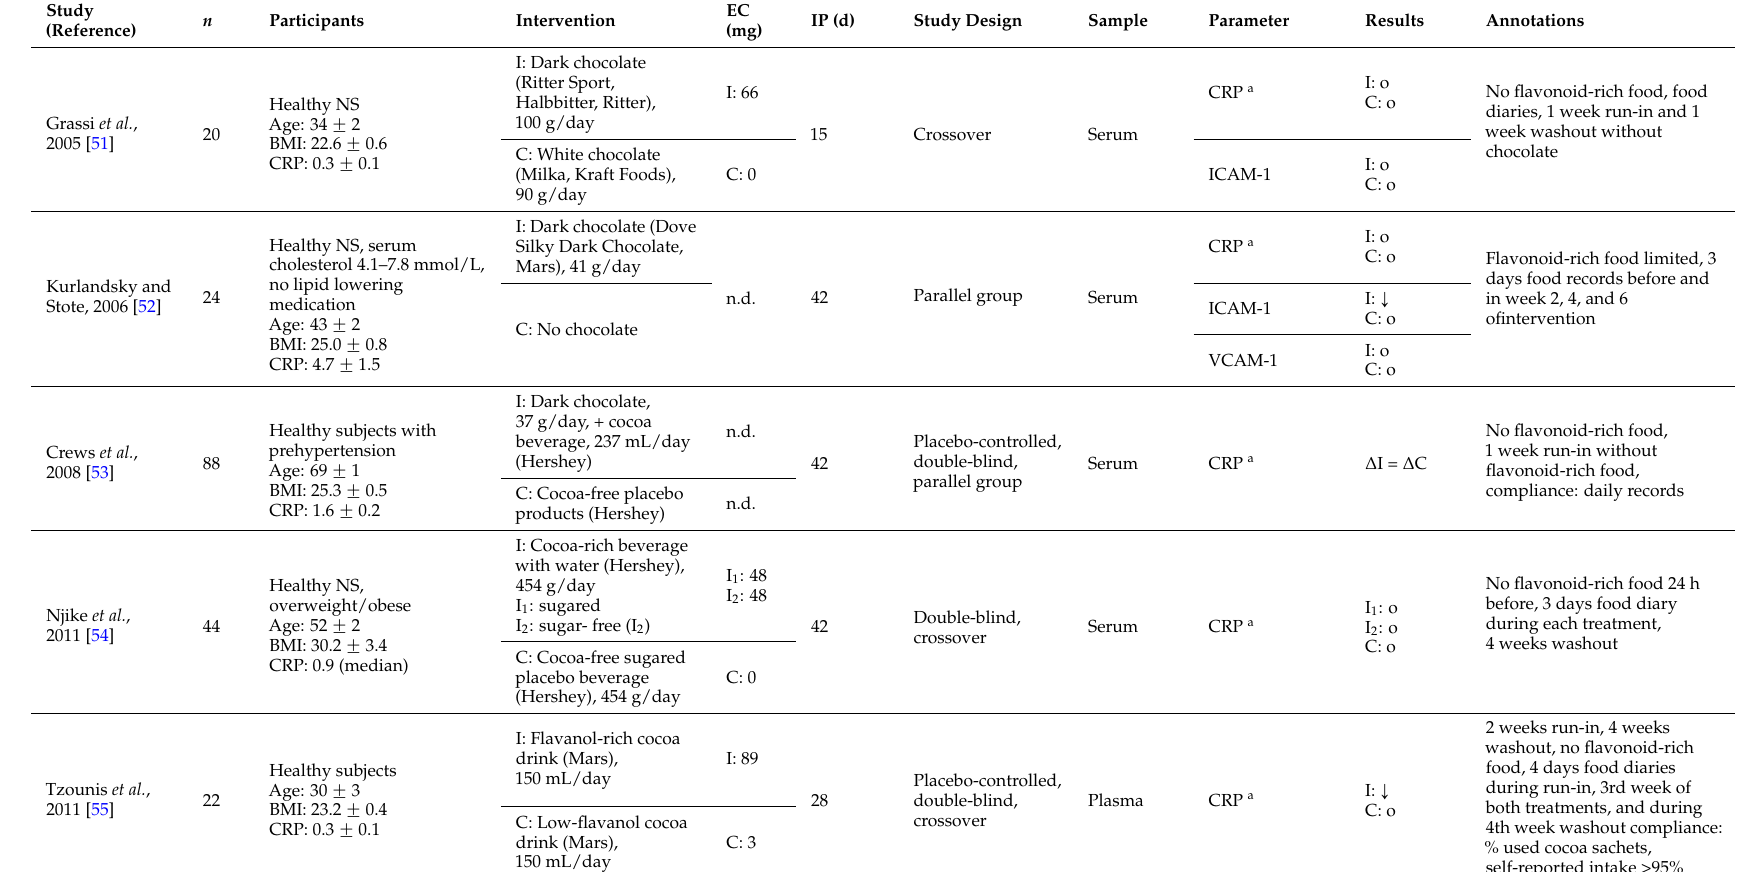
Table 2. Effect of regular cocoa consumption on inflammation in healthy subjects—results from randomized, controlled